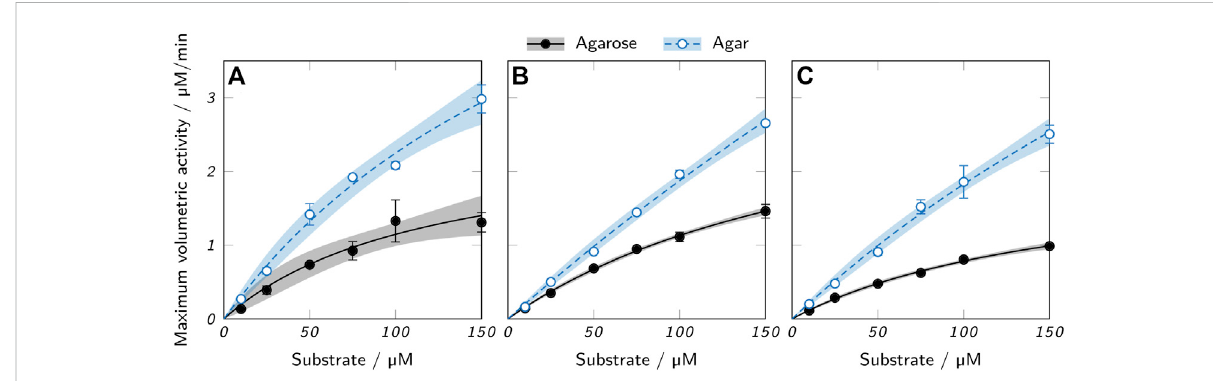
FIGURE 10 Activity assays of printed low-melt agarose and agar cylinders containing 100 nM AaEst2 and (A) 3%, (B) 4.5% and (C) 6% polymer. The data points represent meanvalues ± standard deviation ( n = 3) and were fi tted with aMichaelis-Menten equation. 95%con fi dence intervals are displayed as shaded